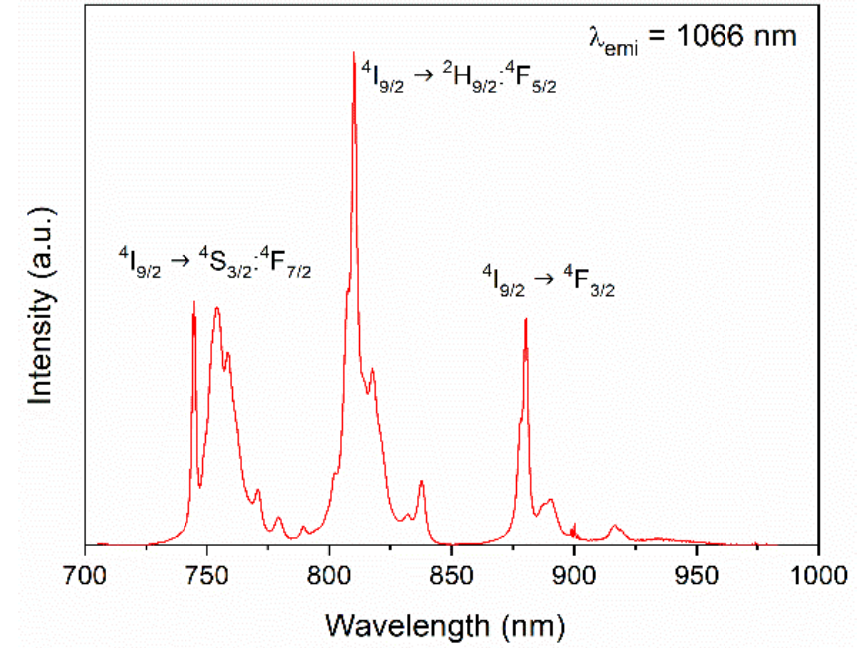
Figure 3. Excitation spectra of the Nd (0.2%):LuVO 4 nanoparticles.